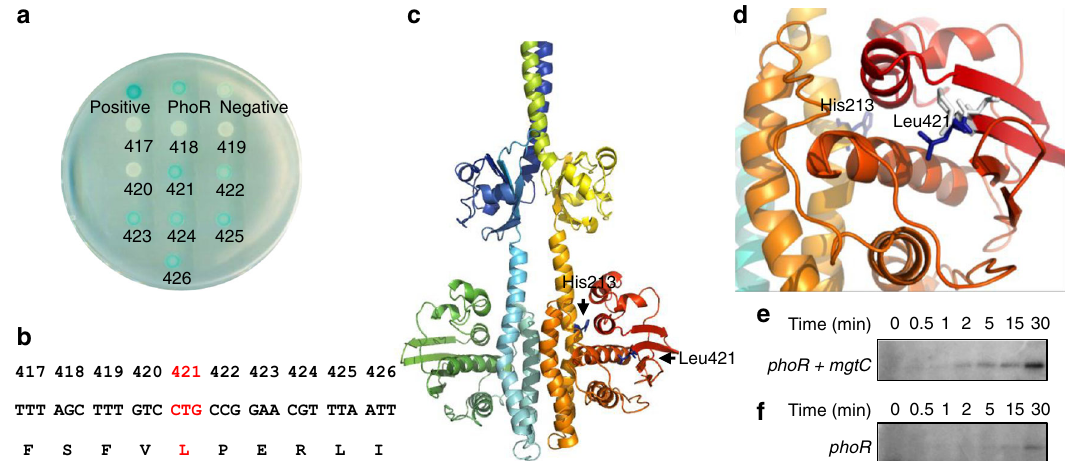
Fig. 3 Leu421 of the PhoR protein is required for MgtC interaction. a Bacterial two-hybrid assay between the MgtC and wild-type PhoR protein or its derivatives. Escherichia coli BTH101 strains harboring two plasmids, pUT18 and pKT25 derivatives expressing the C-terminal fusion of the cyaA T18 fragment to the mgtC coding region and N-terminal fusions of the cyaA T25 fragment to either the coding regions of the full-length phoR (PhoR), phoR 1 – 417 (417), phoR 1 – 418 (418), phoR 1 – 419 (419), phoR 1 – 420 (420), phoR 1 – 421 (421), phoR 1 – 422 (422), phoR 1 – 423 (423), phoR 1 – 424 (424), phoR 1 – 425 (425), phoR 1 – 426 (426), and mgtR (positive) genes or the pKT25 empty vector (negative) were indicated. Cells were spotted onto LB plates containing 80 μ M X-Gal and 0.1 mM IPTG and incubated at 30 °C for 40 h. Blue colored colonies indicate a positive interaction. See also Supplementary Fig. 3. b The amino acid sequence of the PhoR protein corresponding to amino acids 417 – 426. c A modeled structure of the PhoR dimer predicted from a homology-modeling program (Phyre2) based on the crystal structure of Streptococcus mutans VicK (PDB: 4I5S). Leu421 is located at the outer surface of the CA domain and is in parallel to His213 in the DHp domain, which is required for autophosphorylation. The positions of Leu421 in the CA domain and His213 in the DHp domain are indicated by arrows. d A magni fi ed side view of PhoR in c including Leu421 in the CA domain and His213 in the DHp domain. The Leu421 and His213 residues are indicated with blue sticks and Leu421-neighboring residues (Val420 and Pro422) are indicated with pale gray sticks. See also Supplementary Fig. 4. e , f Autophosphorylation assay to determine the rate of PhoR phosphorylation. Levels of PhoR-P following incubation of membrane vesicles prepared from Salmonella expressing PhoR in the presence ( e ) or absence of MgtC ( f ) with [ γ 32 P] ATP at the indicated times. Bacteria were grown for 3 h in N-minimal media containing 10 mM Mg 2 + and then for an additional hour in the same media containing 0.5 mM Mg 2 + , 0.25 mM IPTG, and 1 mM L -arabinose